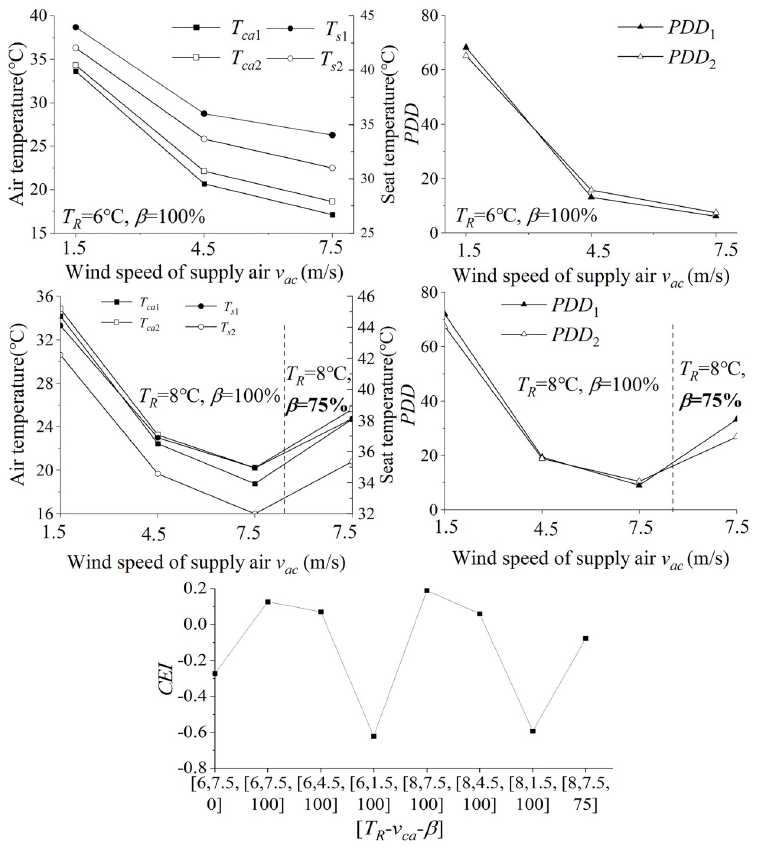
Fig 12. Influence of different parameter combinations in 7.5 m/s on scenario 2. The parameter combination [8, 7.5, 100] wins the higher score.